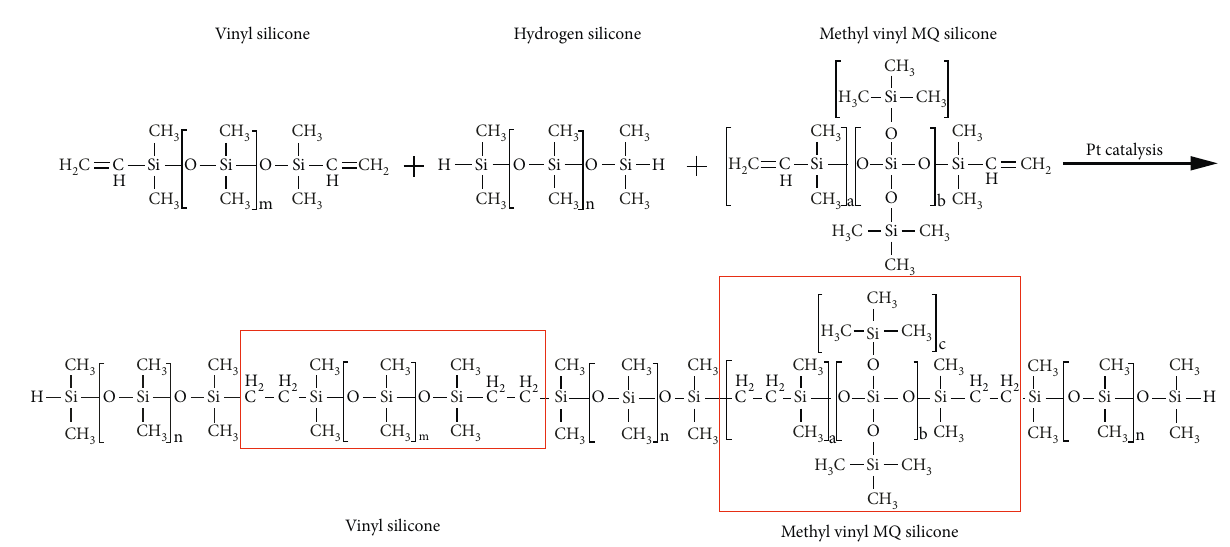
Figure 3: Reaction of the process of coating preparation.